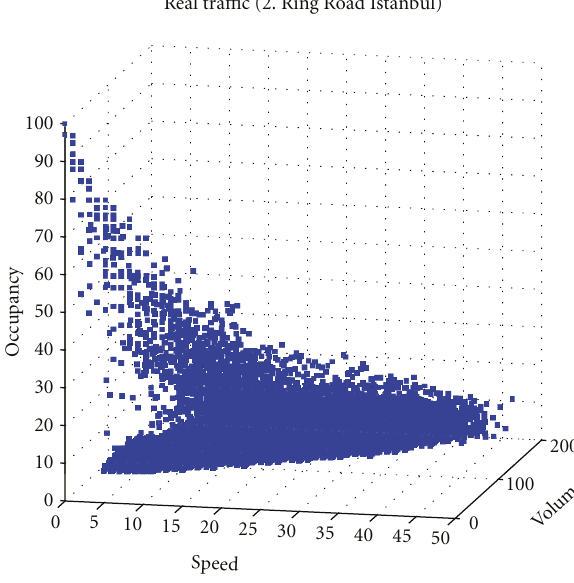
Figure 17: Real Tra ffi c data from 2.Ring Road in Istanbul (by 7